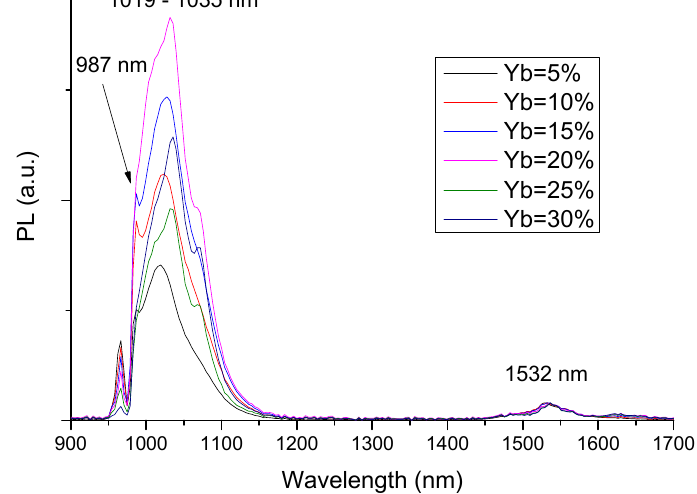
Figure 6. Normalized PL emission spectra of Yb/Er co-doped aluminosilicate bulk glass samples, excited at 970 nm.